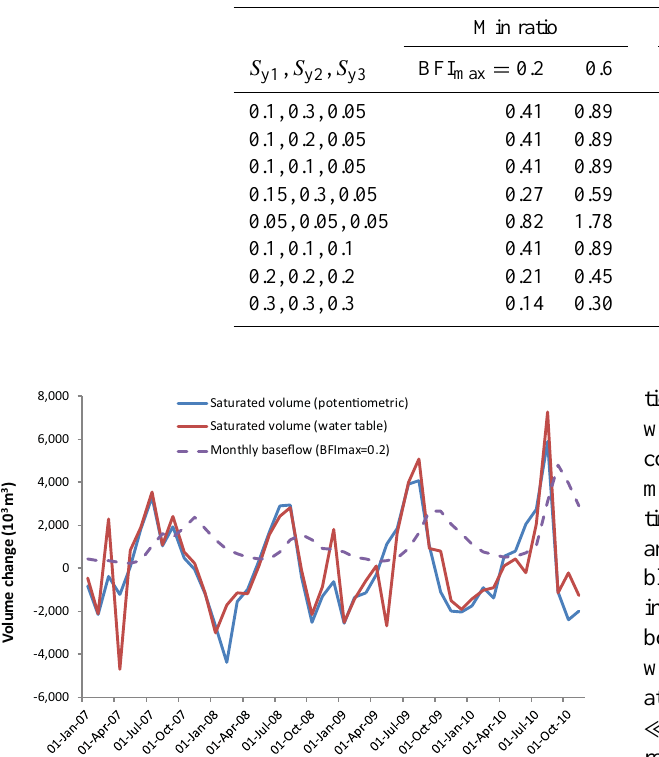
Table 2. Minimum, median and 90th percentile values for the ratio of monthly Eckhardt filter baseflow to “water table” volume changes using a range of specific yields ( S y 1 – Wangerrip Group, S y 2 – alluvium, S y 3 – Heytesbury Group aquitards). Filtered baseflow time series were calculated using an a value of 0.988 and BFI max values of 0.2 or 0.6. Only months with declining volume changes were used in the analysis.